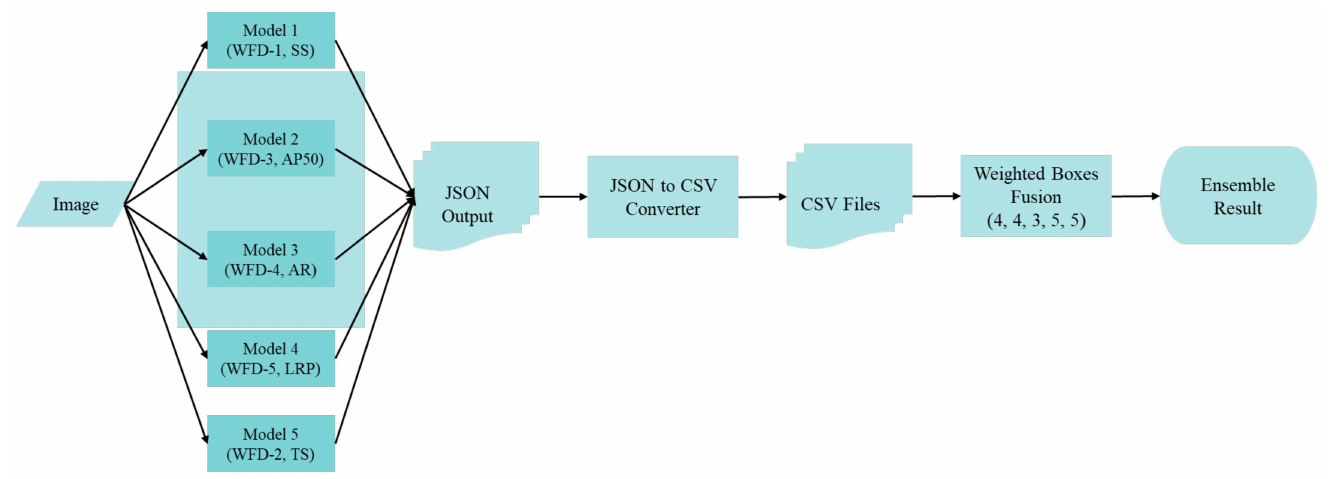
Figure 8. Proposed WFD-C ensemble models based on weight boxes fusion. Table 2. Submodels and weight coefficients of WFD ensemble